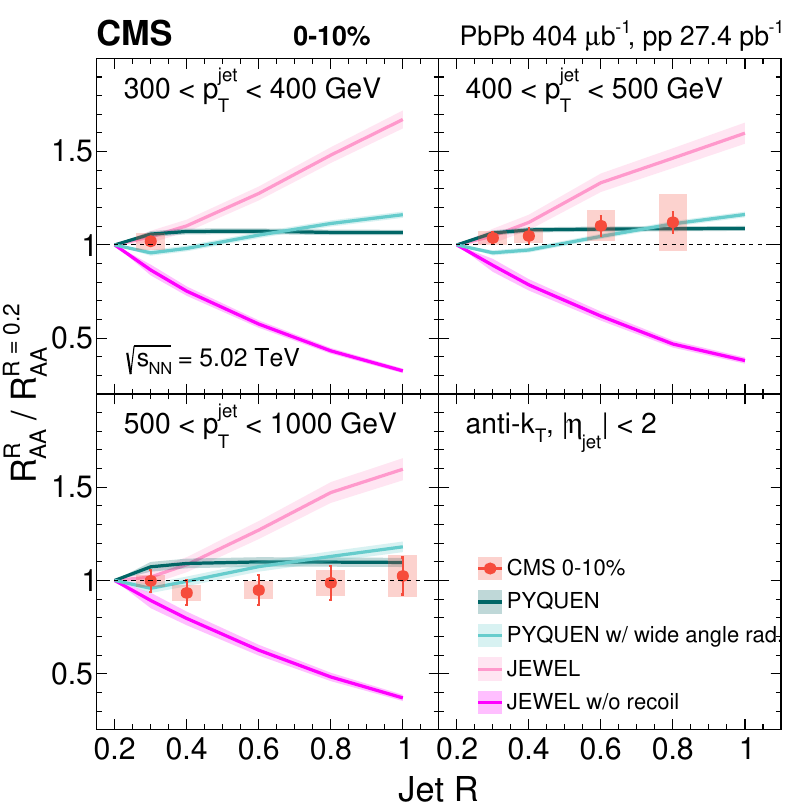
ratio for jets with | η jet | < 2 . 0 as a function of R for R = 0 . 3 – 1 . 0 with respect Figure 10 . The R AA to R = 0 . 2 , in various p jet ranges for the 0–10% centrality class. The statistical uncertainties of data T are shown as the vertical lines, whereas the systematic uncertainties are shown as the shaded boxes. The width of the boxes carries no meaning. The predictions from Jewel (fuchsia and pink) and pyquen (teal and turquoise) generators, shown with the colored bands, are compared to the